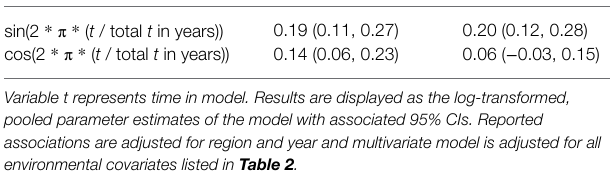
TABLE 6 | Univariate and multivariate sinusoidal function of tdh across years. Model coefficients Univariate Multivariate